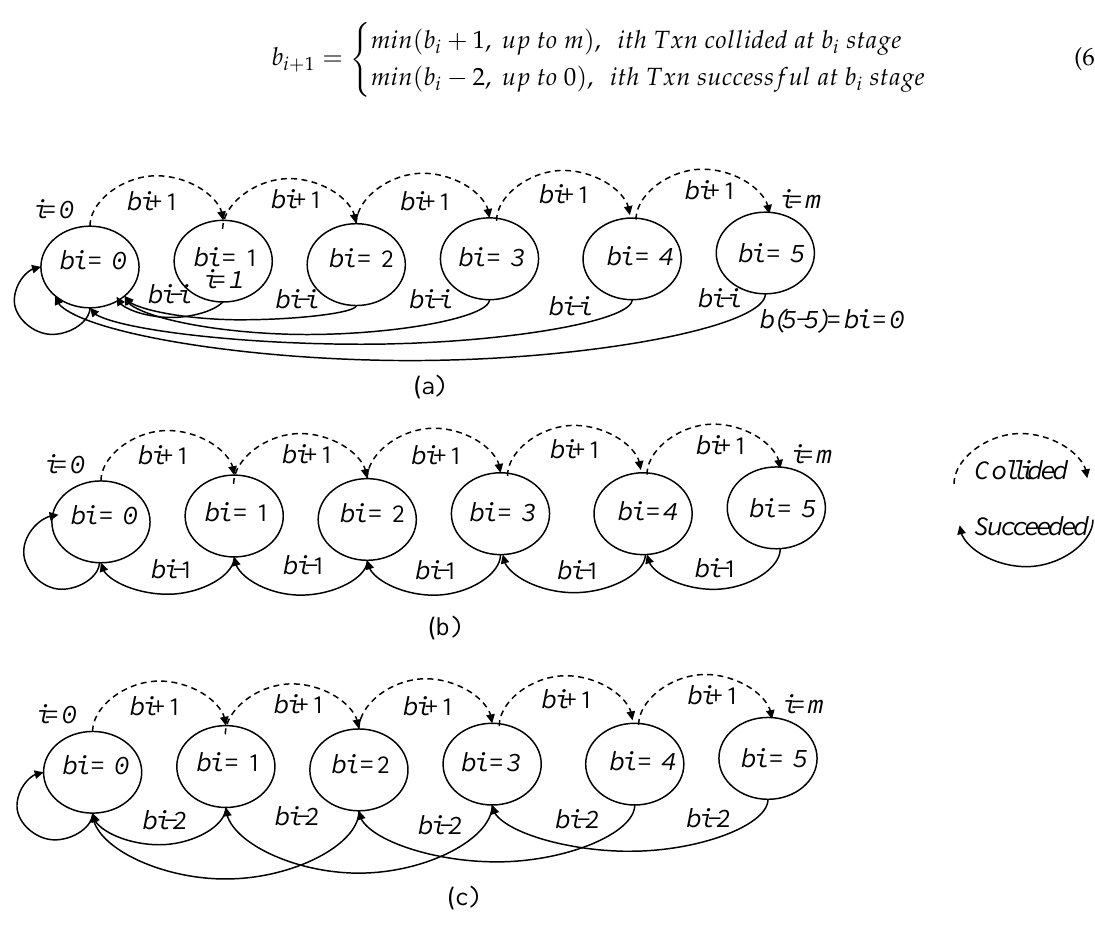
Figure 4. Back-off stage mechanism after collision/successful transmission; ( a ) back-off stage incre- ment/reset in BEB; ( b ) back-off stage increment/reset in COSB; and ( c ) back-off stage increment/reset in the proposed mechanism